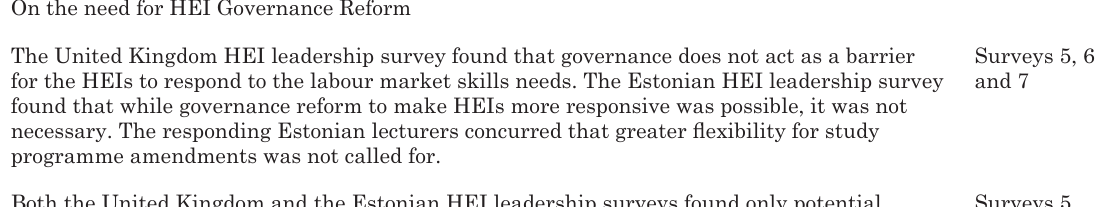
Table 6. Summarized findings relating to HEI governance reform as a solution